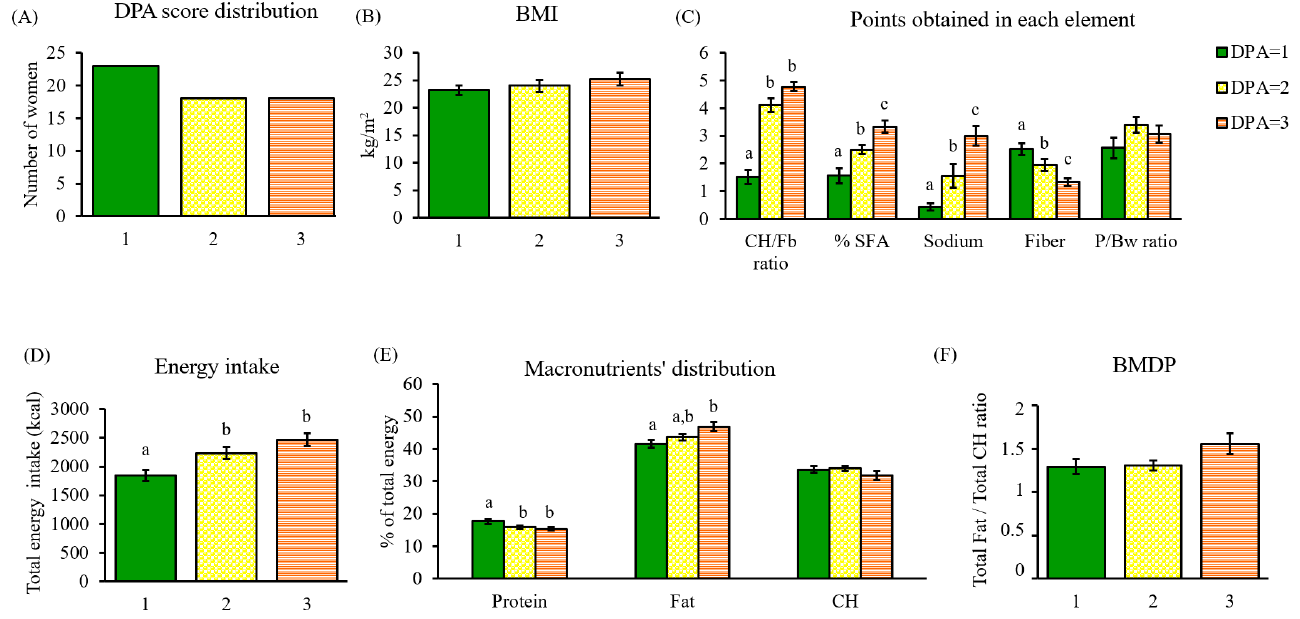
Figure 5. Dietary characterization of the cohort through DPA. ( A ) DPA score distribution; ( B ) BMI of women classified by their DPA score; ( C ) points obtained in each DPA element and classified by DPA score; ( D ) total energy intake (kcal) associated with the DPA score; ( E ) percentage of total energy coming from macronutrients in each DPA score; ( F ) total fat/total carbohydrate (F/CH) ratio defining the BMDP in each DPA score. Data are mean ± SEM ( n = 23, 18, and 18, respectively). Statistics: groups with different letters are significantly different (LSD post hoc one-way